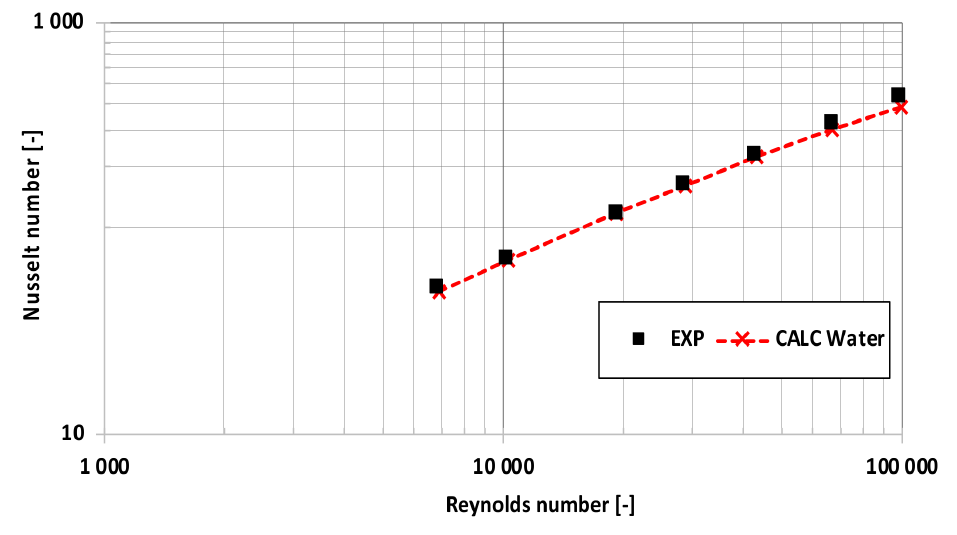
Figure 2. Validation of numerical predictions for carrier liquid flow. D = 0.02 m; T w = 293.15 K, q = − 500